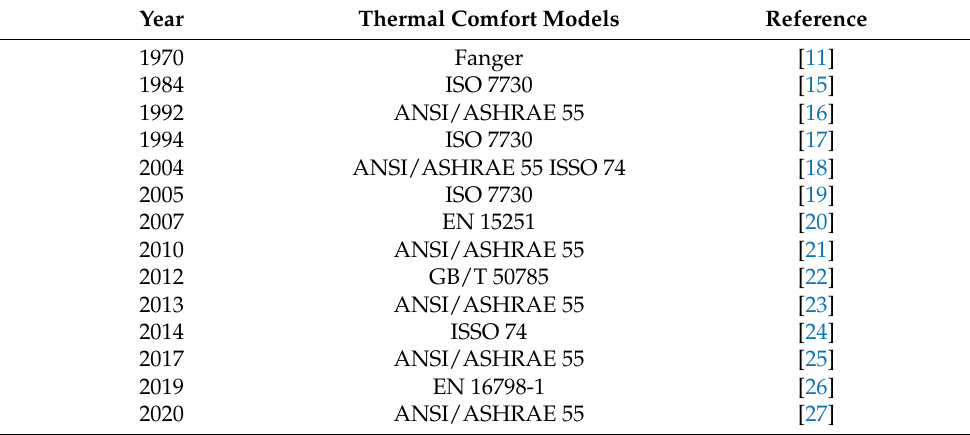
Table 1. Evolution of thermal comfort